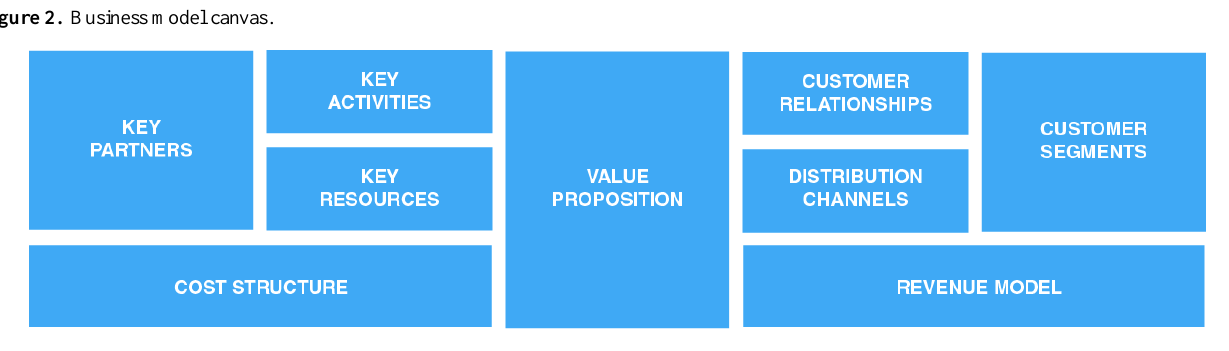
Figure 2. Business model